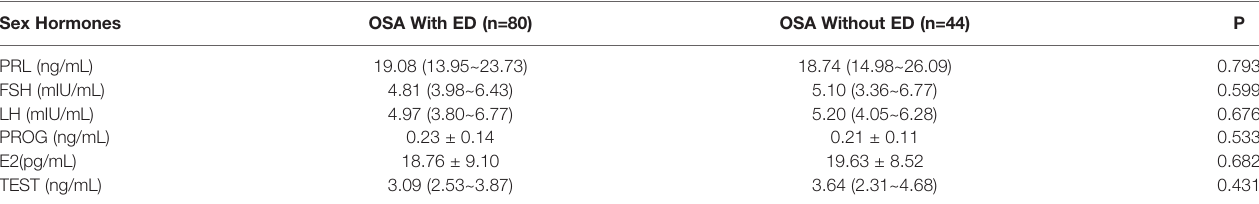
FSH, Follicle stimulating hormone; LH, luteinizing hormone; and TEST, testosterone; E2, estradiol; PROG, progesterone; and PRL, prolactin.